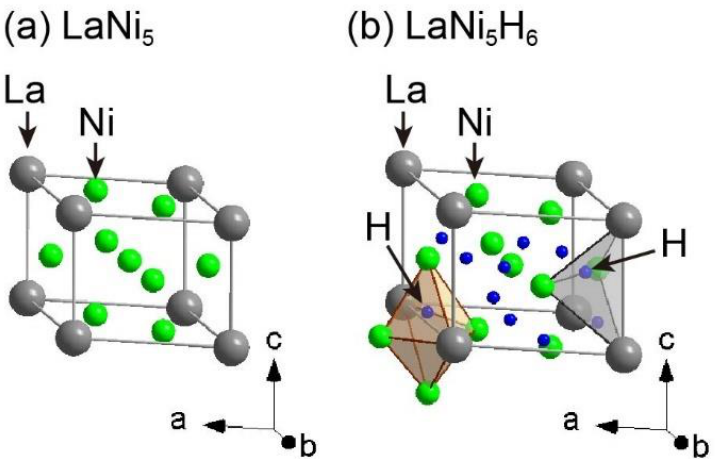
Figure 1. Crystal structures of ( a ) LaNi 5 with a = 5.013 Å and c = 3.987 Å in the space group P 6/ mmm (No. 191) [21], and ( b ) LaNi 5 H 6 with a = 5.410 Å and c = 4.293 Å in the space group P 31 m (No. 157) [18]. Gray, green, and blue spheres indicate La, Ni, and H atoms, respectively. The brown octahe- dron and gray tetrahedron denote H atomic sites at 3c and 6d, respectively.